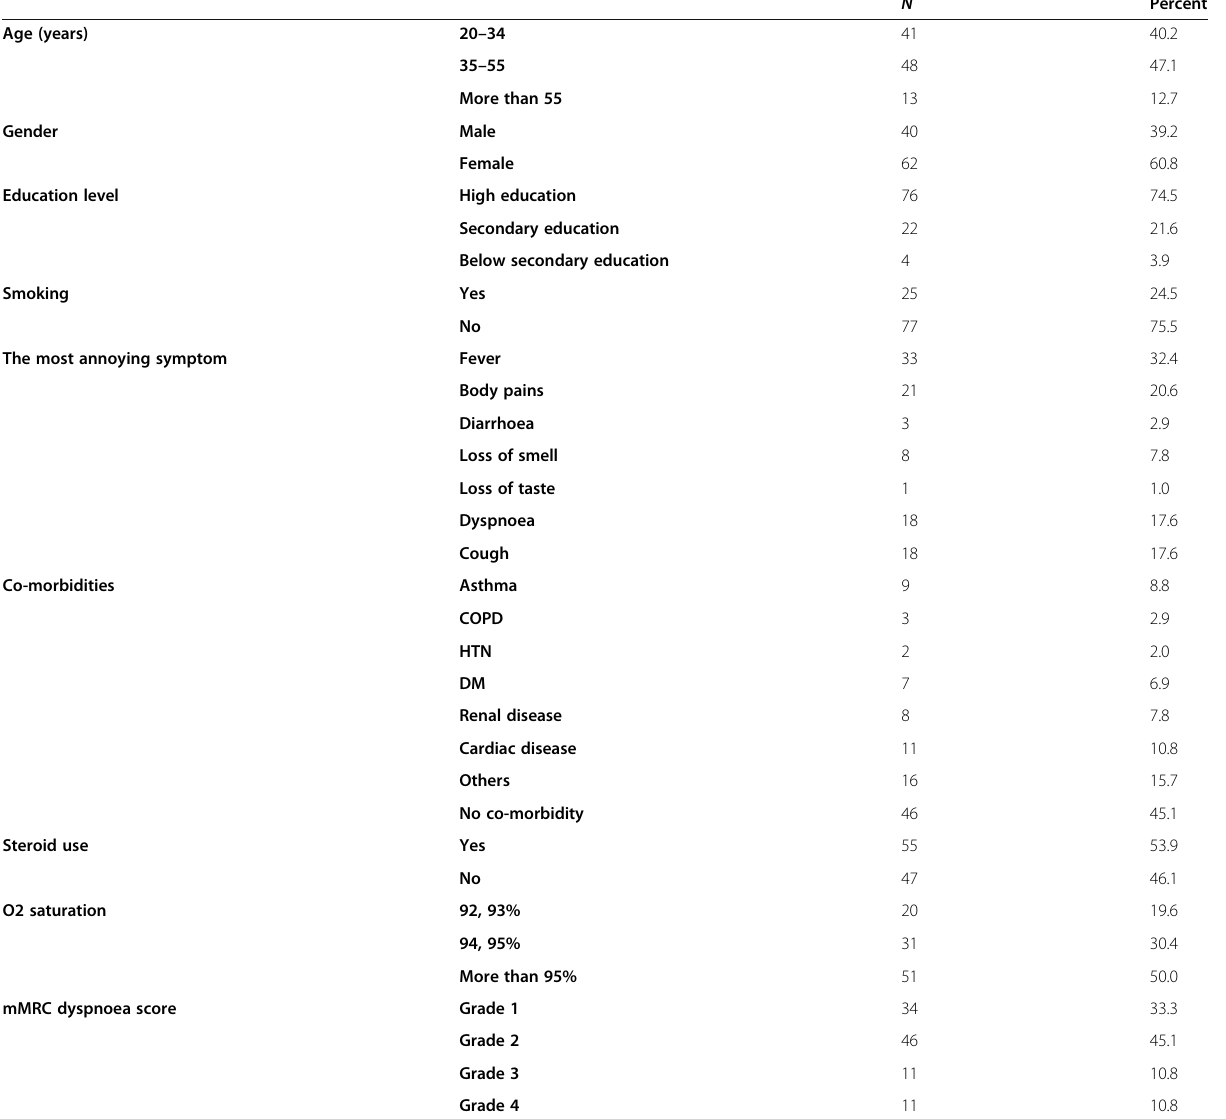
Table 1 Characteristics of the study